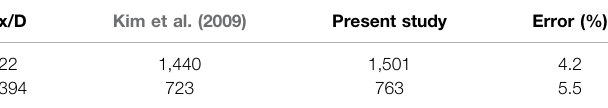
TABLE 2 | Local heat transfer coef fi cient for two channel lengths: comparison between the present work and the work of Kim et al. (2009). x/D Kim et al. (2009) Present study Error (%) 22 1,440 1,501 4.2 394 723 763 5.5